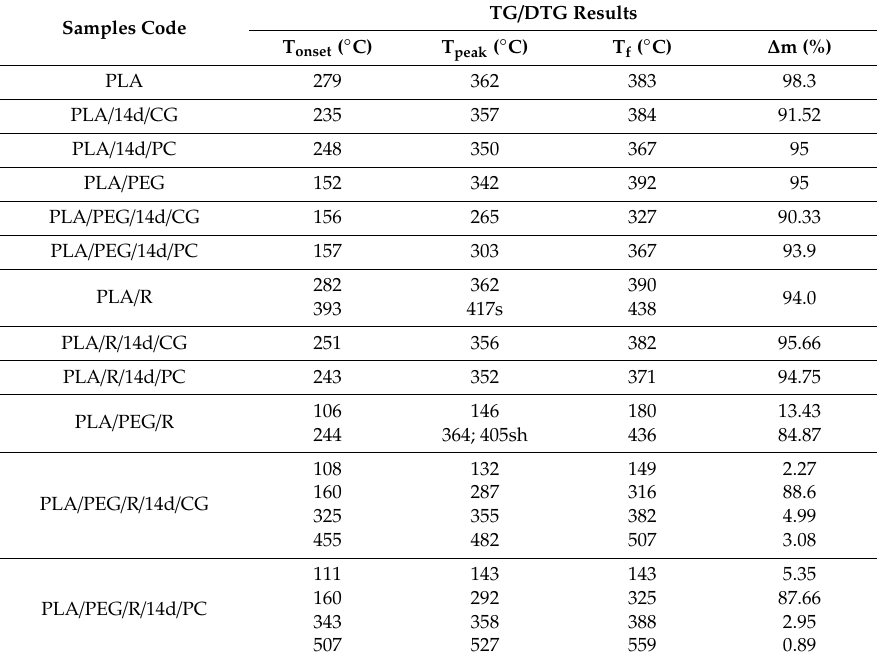
temperature of process and Δ m—mass loss at the end of each process); sh—shoulder.